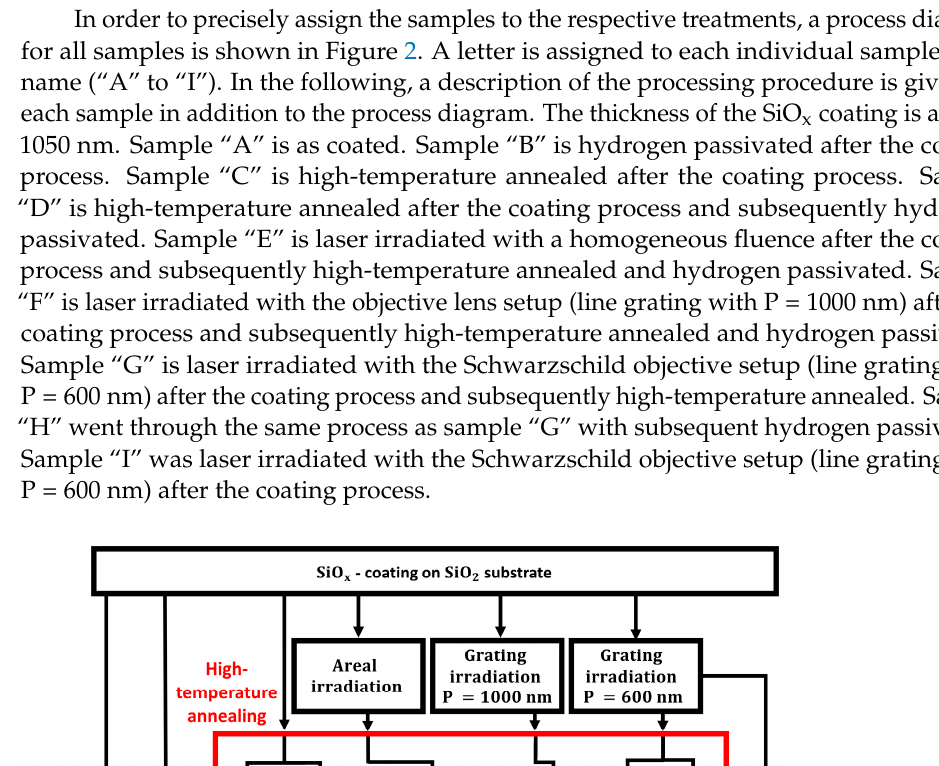
Figure 1. Optical setup to produce a line grating by ArF excimer laser irradiation of the samples. An attenuator offers fluence adjustment. A binary fused silica phase mask in contact with a transparent chromium mask is used. The structure of the mask, as well as the first diffraction orders, are shown enlarged, indicated by the red marking. A lens is used to recombine the first orders of the split-up beam on the sample surface (the Schwarzschild objective is shown here as an example). The sizes are not to scale. Crucial details of the setups are shown in Table 1. Table 1. Crucial parameters of the three di ff erent laser setups used for sample irradiation. Laser systems from Coherent, Gö tt ingen, Germany.